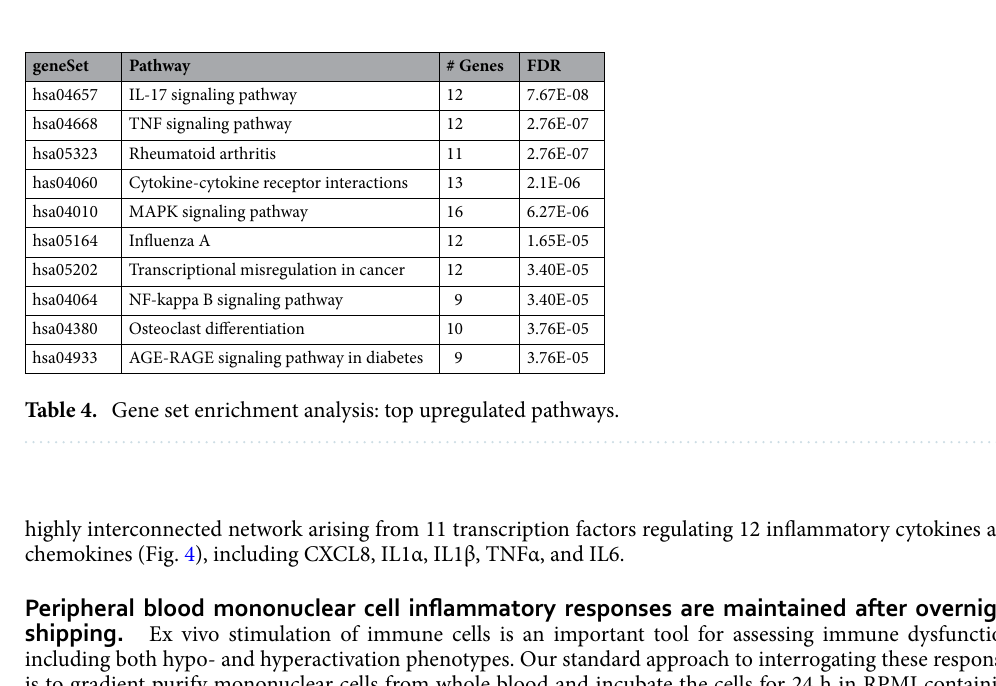
Table 3. Transcriptional analysis: top coexpression module genes after 24 hours. 1 FI = fold induction.